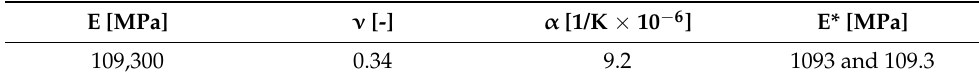
Figure 3. An exemplary strain–temperature increment relationship. Table 1. Material properties of considered